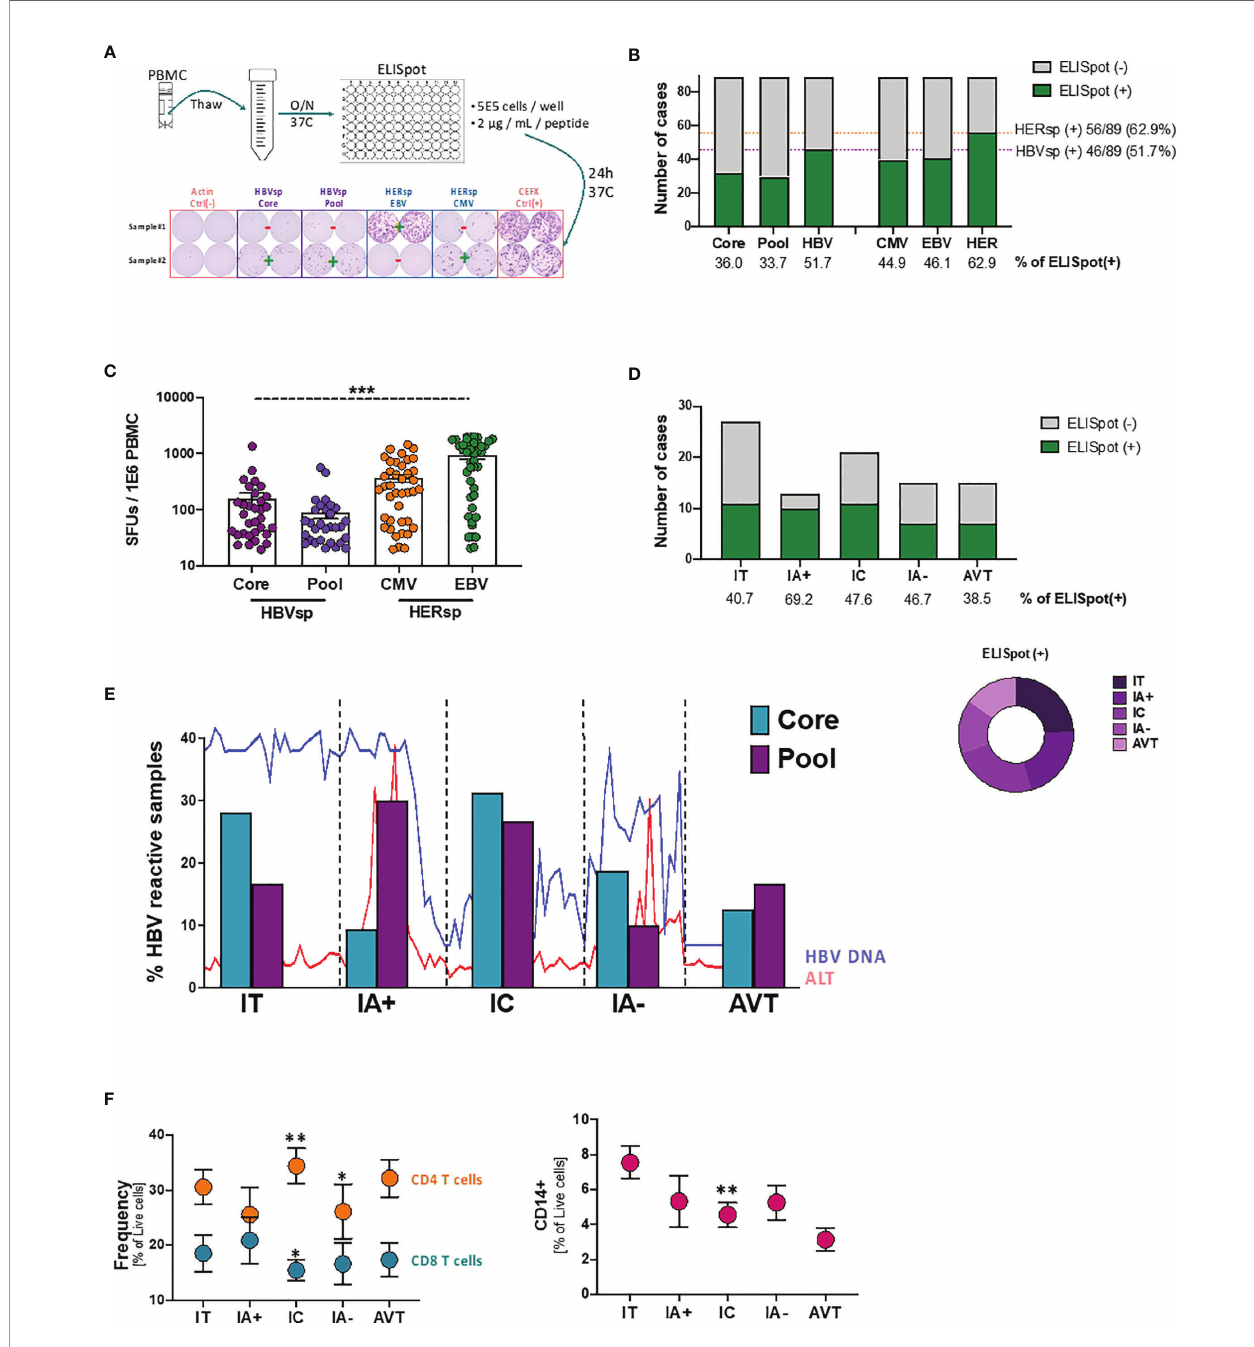
FIGURE 1 | Ex vivo HBV-speci fi c response evolves with clinical progression. (A) Schematic representation of the ex vivo ELISpot work fl ow with representative example of the response levels. (B) Number of samples with ex vivo ELISpot reactivity. HBV number of cases shows CORE and/or POOL while HER (HERPES) number of cases shows EBV and/or CMV. (C) Magnitude of the Ag-speci fi c response, as measured as spot-forming units (SFUs) per million PBMCs, among the different stimulations. *** p < 0.0001; Kruskal-Wallis one-way analysis of variance. (D) Number of samples with ex vivo HBV- speci fi c (core and/or pool) reactivity among the different clinical groups. (E) Evolution of the individual HBV-speci fi c stimulations (CORE and POOL) with clinical progression. Lines show the variability of HBV DNA and ALT levels within each group. (F) Frequency of T cells (left panel) and CD14+ monocytes (right panel) among the different clinical groups. * p < 0.05; ** p < 0.01; Mann Whitney U test. IT, Immune Tolerant; IA+, HBeAg+ Immune Active; IC, Immune Control; IA-, HBeAg- Immune Active; AVT, Anti-Viral